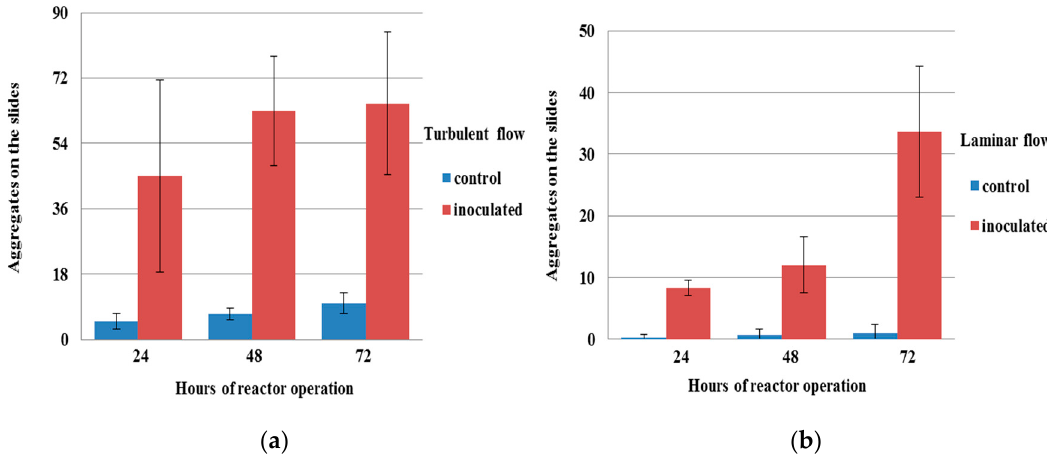
Figure 2. Number of aggregates on the reactor slides for both the control and inoculated cultures after 24, 48, and 72 h ( a ) in turbulent flow and ( b ) in laminar flow.